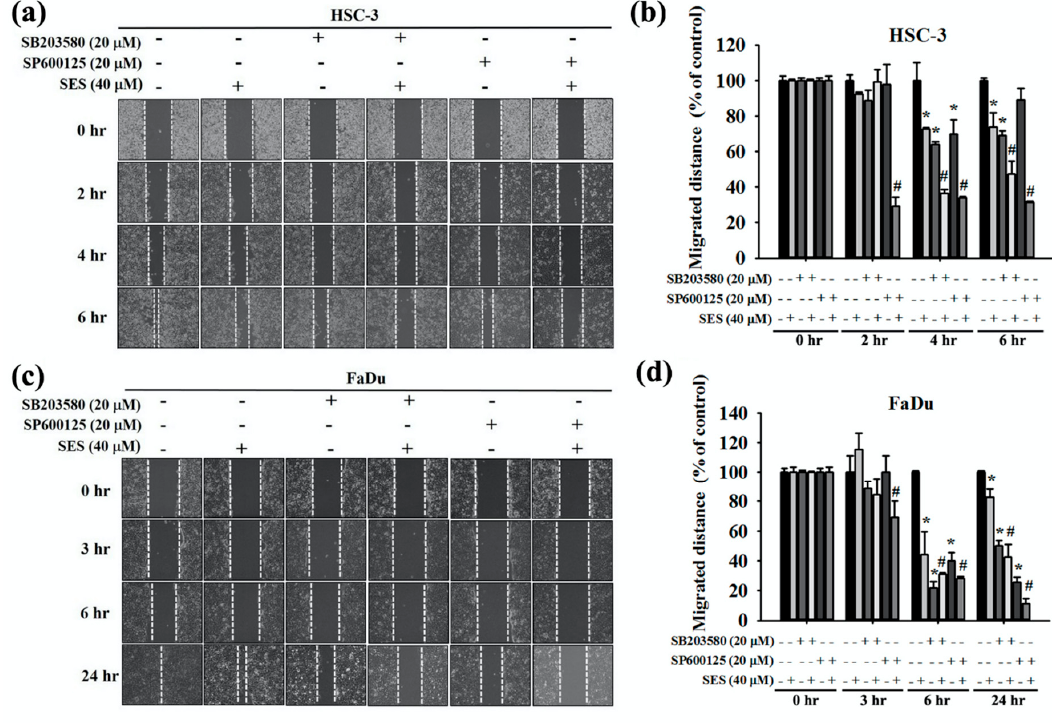
Figure 7. The relationship between cell motility and MAPK inhibitors in human oral cancer cells following sesamin treatment. ( a ) HSC-3 and ( c ) FaDu cells were pretreated with SP600125 or SB203580 for 1 h and then incubated in the presence or absence of 40 μ M SES for 24 -h. After that, wound-healing assays were performed at different time points. ( b ) HSC-3 cells shown at 2, 4, and 6 h, depicting the wound closure distances for quantitative analysis. ( d ) FaDu cells shown at 3, 6, and 24 h, depicting the wound closure distances for quantitative analysis. The values represent the means ± SD of at least three independent experiments. * p < 0.05, compared with the control group. # p < 0.05, compared with the SES-treated group.